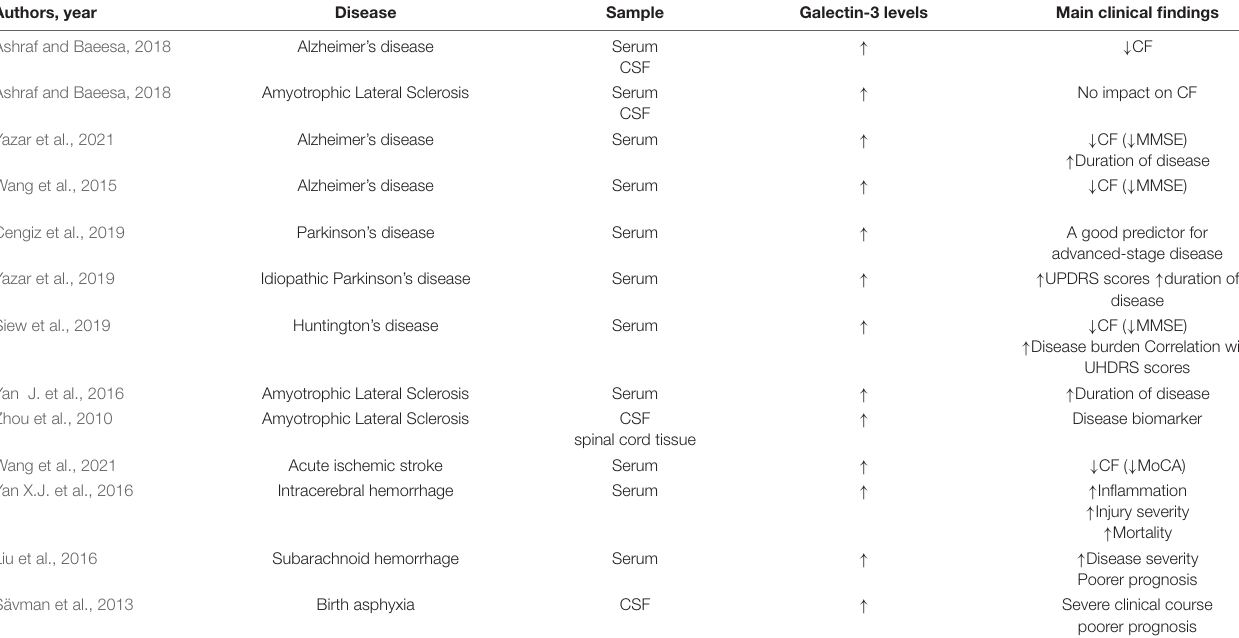
TABLE 1 | Brief summary of clinical studies on the level and impact of Galectin-3 on main clinical findings in various neurological disorders. Authors,